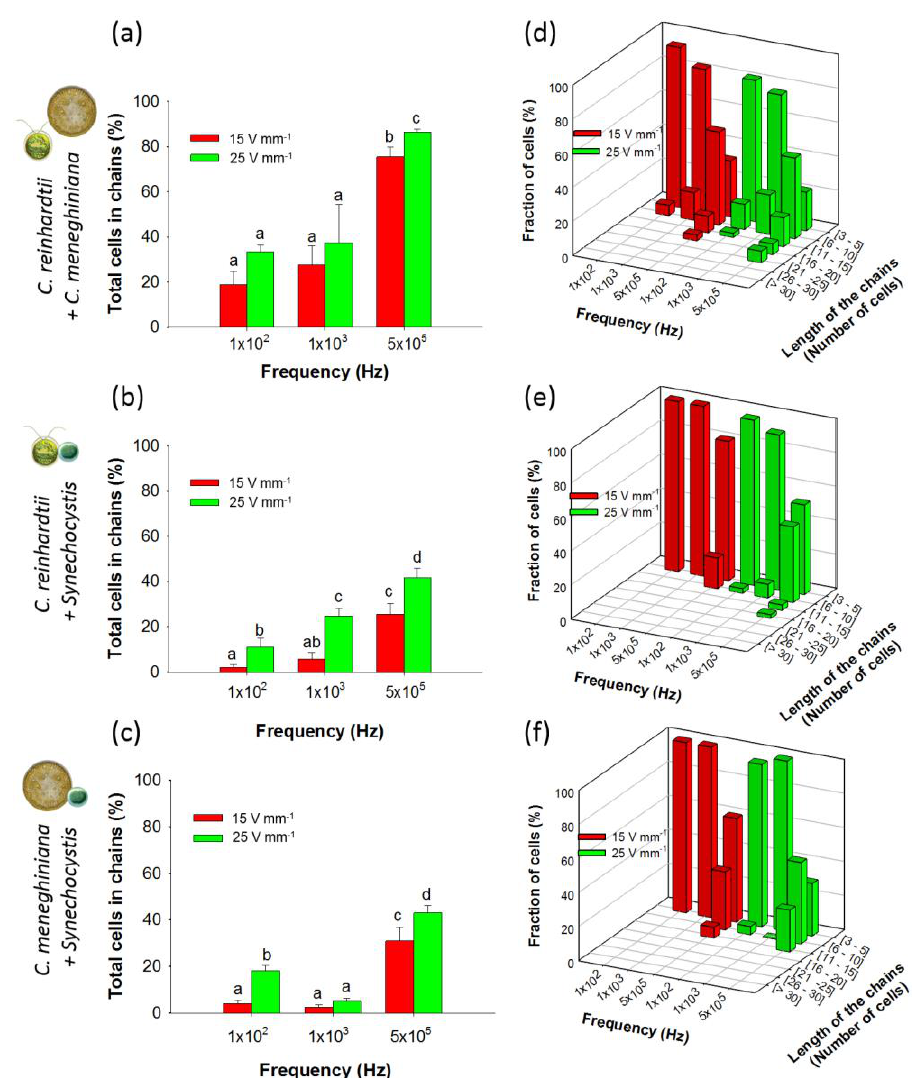
Figure 4. Chaining efficiency and length of mixed chains (1:1) at 15 and 25 V·mm −1 and at 100 Hz, 1 kHz and 500 kHz after 5 min of AC field application. Histograms represent the total percentage of cells in chains for: ( a ) C. reinhardtii + C. meneghiniana ; ( b ) C. reinhardtii + Synechocystis sp.; and ( c ) C. meneghiniana + Synechocystis sp.; 3D histograms represent the fraction of cells in mixed chains of different lengths for: ( d ) C. reinhardtii + C. meneghiniana ; ( e ) C. reinhardtii + Synechocystis sp.; and ( f ) C. meneghiniana + Synechocystis sp.; Different letters indicate significant differences between the measurements obtained by one-way ANOVA and the Student–Neumann–Keuls method ( p < 0.05). Cell concentrations: 2.5 × 10 6 cells·mL −1 .